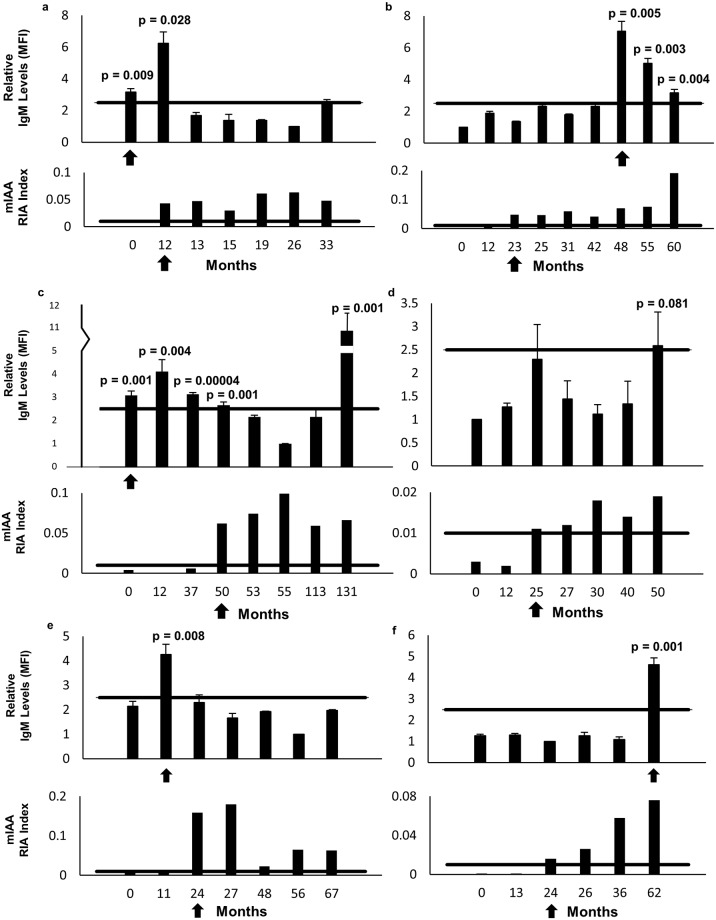
Serial isotype-specific testing for insulin autoantibodies.(a-f) Longitudinal IgM isotype-specific test results (upper) from 6 volunteers that became RIA positive (lower). Time was calculated in months from the first available sample. Each test was performed in triplicate to generate the mean fluorescence intensity (MFI) for the time-point. The entire time-course for each individual was repeated 3–4 times in independent experiments and the averages of the MFIs were calculated. MFI values were normalized to each volunteer’s intra-course nadir and expressed as fold-change from the nadir. Error bars represent standard deviations of the replicates, each of which was performed in triplicate. Arrows on upper graphs identify the earliest time-point where IgM levels were > 2.5-fold above nadir (horizontal bar) with a p < 0.05. Arrows on lower graphs identify the earliest time-point where RIA was positive (mIAA RIA index > 0.01) by TrialNet testing.